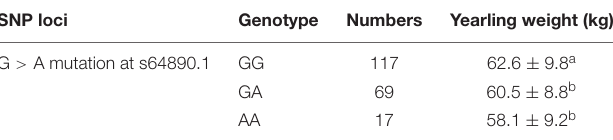
Values with the same superscript for the same column have no significant differences (p > 0.05). Values with different superscript for the same column have significant differences (p < 0.05).